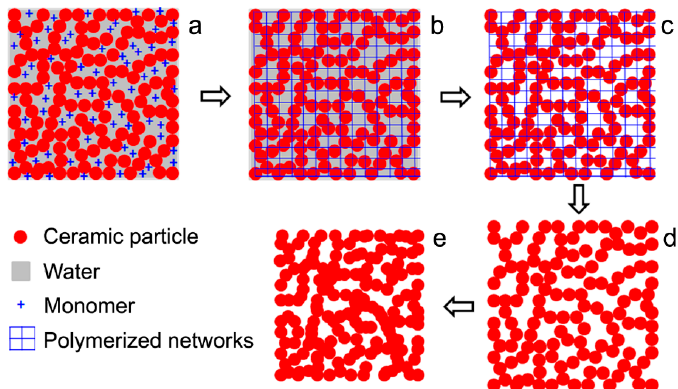
Figure 1. Fabrication steps of porous Al 2 O 3 ceramics by gelcasting, ( a ) Al 2 O 3 suspension; ( b ) polymerization of monomers; ( c ) drying; ( d ) burning out of polymers; and ( e )